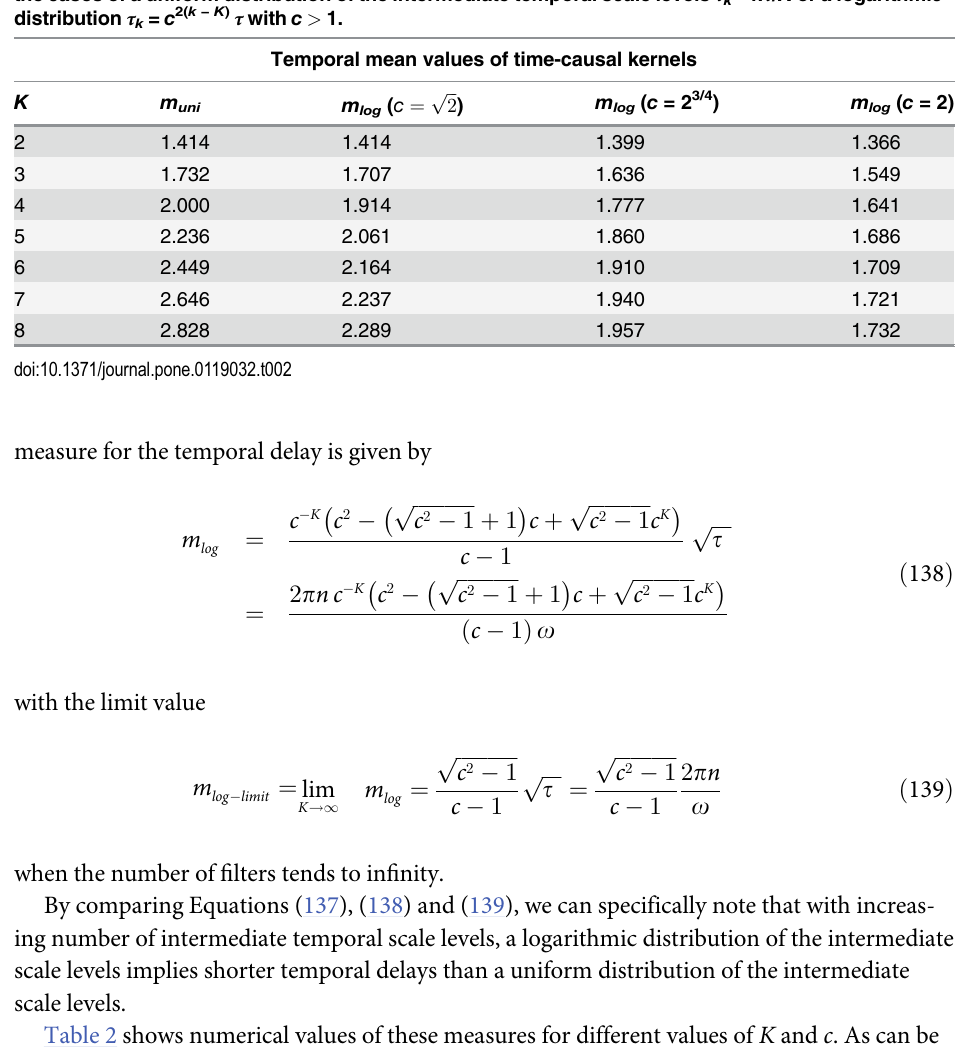
P K in units of m k k ¼ 1